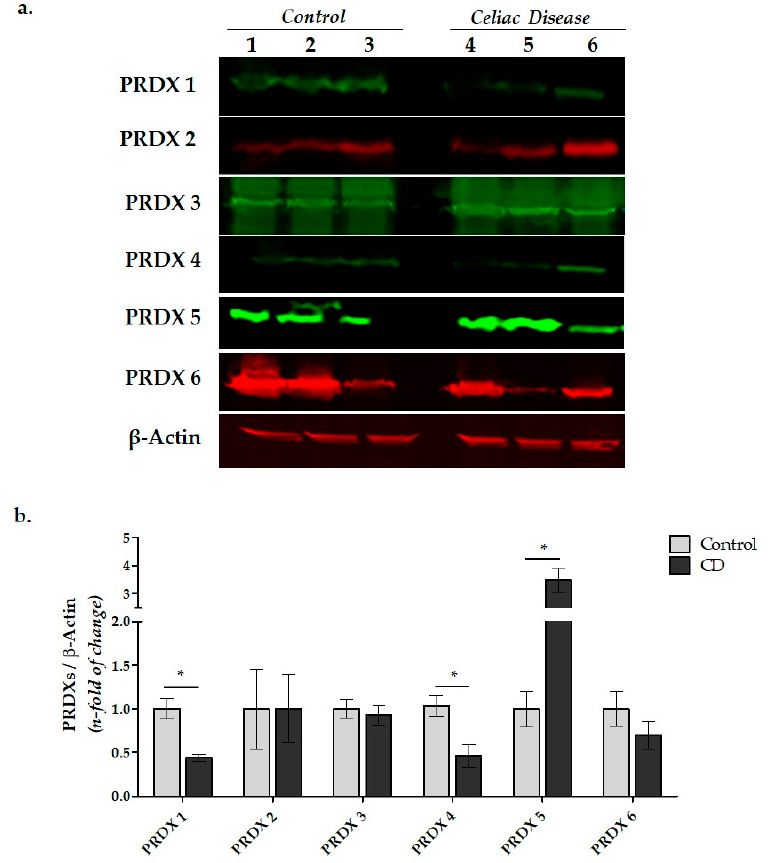
Figure 5. The protein expression levels of the PRDX isoforms in the duodenal biopsy samples. ( a ) Protein expression levels of PRDX -1, -2, -3, -4, -5, and -6 were determined by WB analysis. ( b ) Relative densitometric values of the protein expression levels of the PRDX isoforms. The β -actin signal was used to normalize the data, which were then expressed in arbitrary densitometric units. Data were expressed as the mean ± SEM ( n = 3). * p < 0.05 versus the control